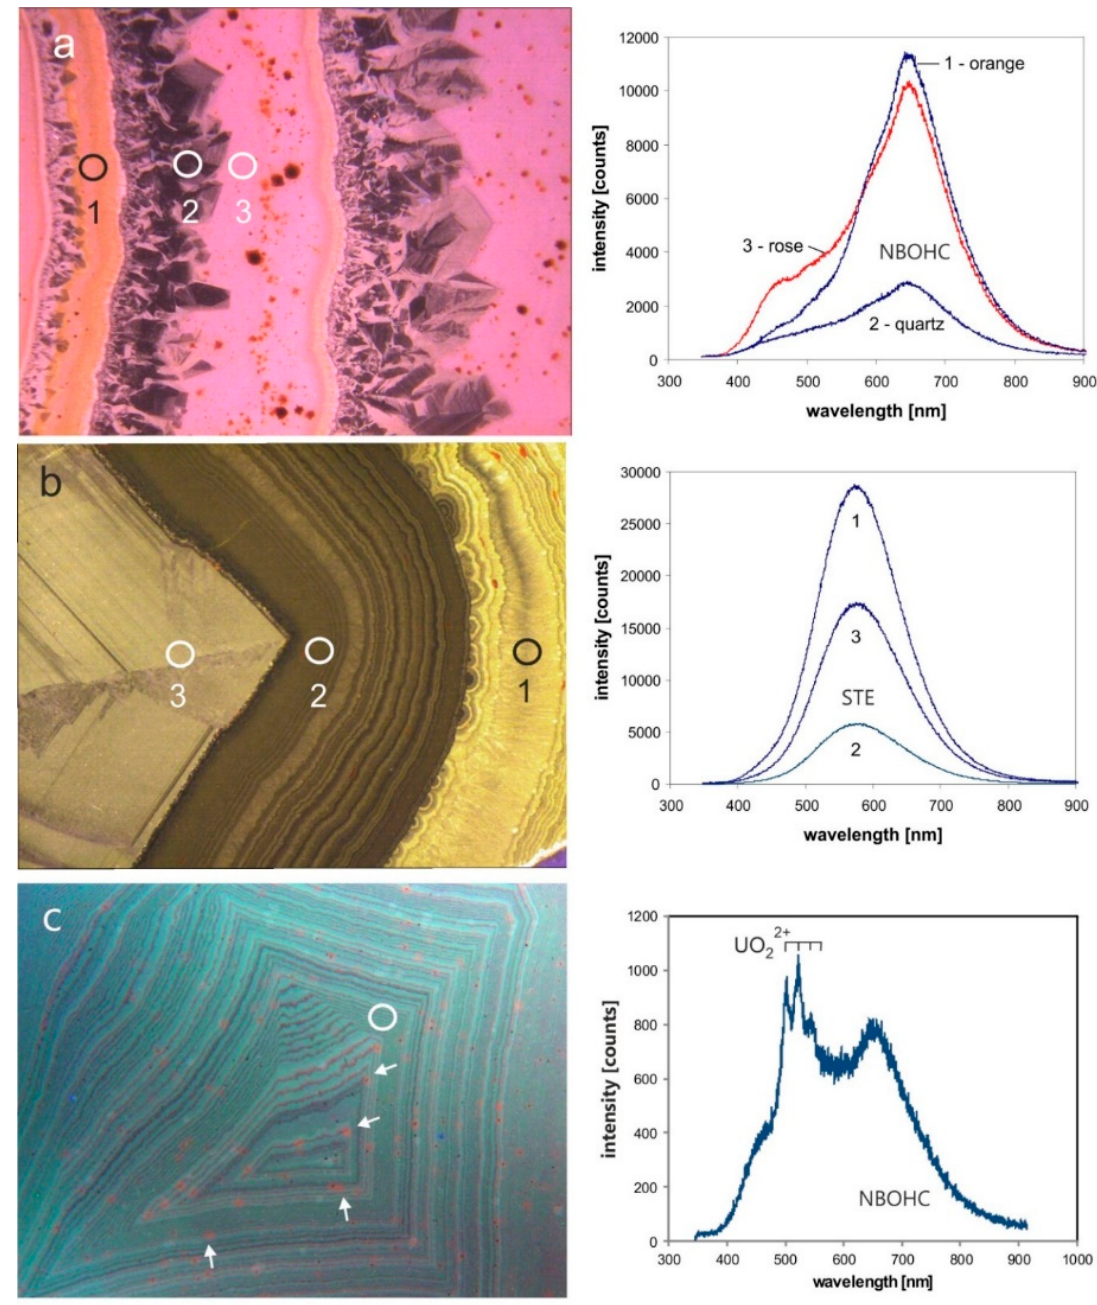
Figure 15. CL micrographs and related CL spectra of agates from different locations and host rocks; the circles mark the analytical spots of spectral measurements; ( a ) sedimentary “Dryhead agate” from the Pryor mountains, Montana (USA) showing growth zones with variable CL dominated by the 650 nm emission (non ‐ bridging oxygen hole center, NBOHC); ( b ) agate in ignimbrite from St. Egidien (Saxony, Germany) with yellow CL; the spectra exhibit a broad emission band around 570 nm (self ‐ trapped exciton, STE) with varying intensities; ( c ) agate in basalt from Soledade, Rio Grande do Sul (Brazil) showing greenish CL; the visible CL color results from the overlapping of a broad band at 650 nm (NBOHC) and multiple peaks between 500 and 600 nm of the uranyl ion (UO 22+ ); note the radiation halos around U ‐ bearing inclusions (arrows).